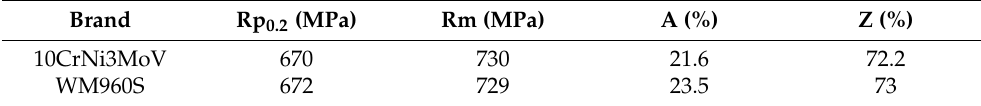
Table 2. Mechanical properties of base metal and welding wire. Brand